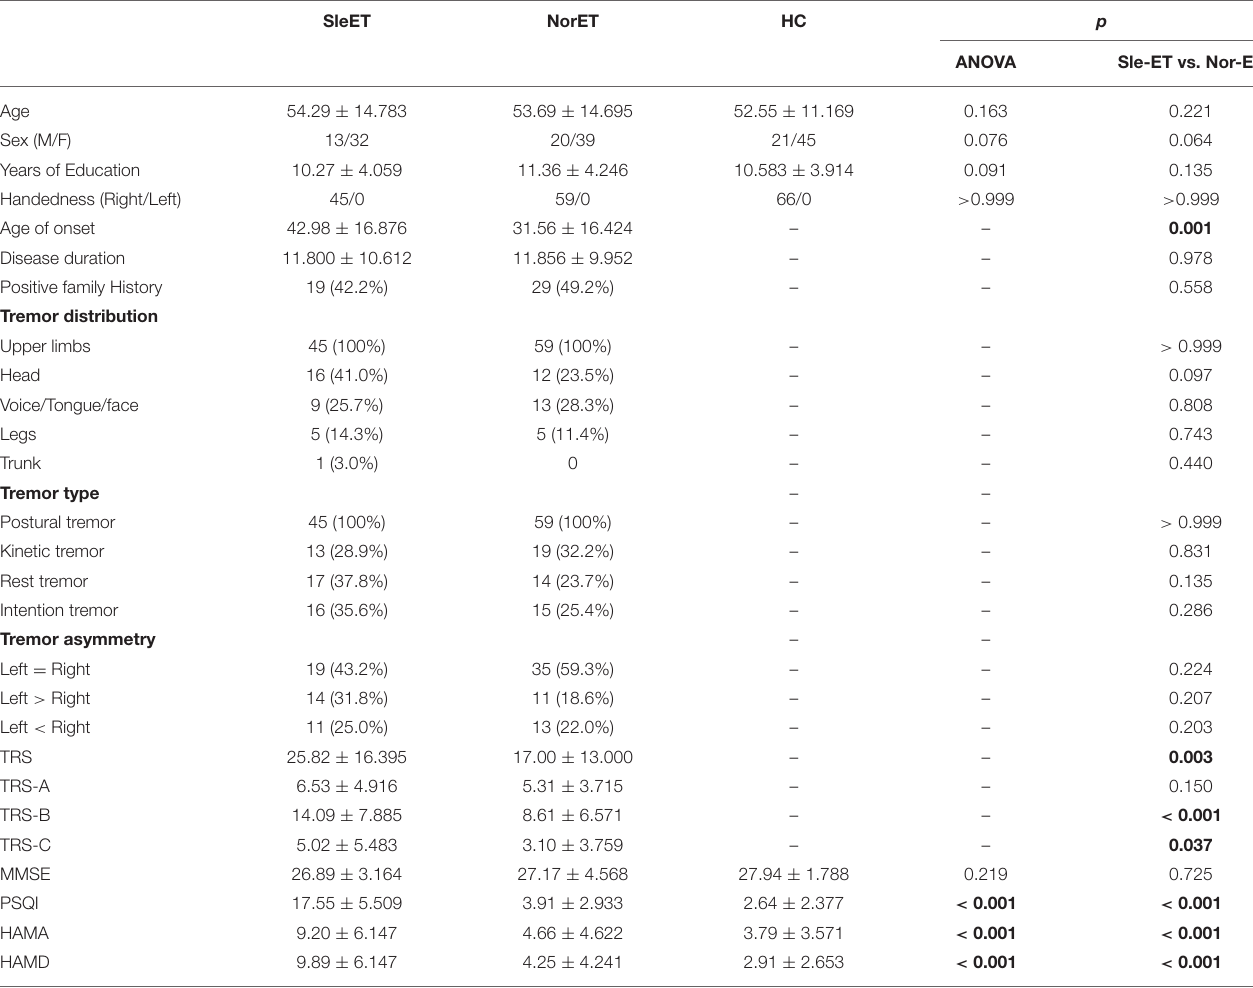
TABLE 1 | Demographic and clinical characteristics of the patients having poor quality of sleep (QoS; SleET), patients having normal QoS (NorET), and healthy control (HC) participants. SleET